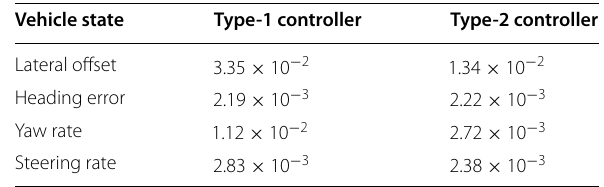
Table 4 Root mean square (RMS) of vehicle states responding to Table 5 Infinite norm of vehicle states responding to